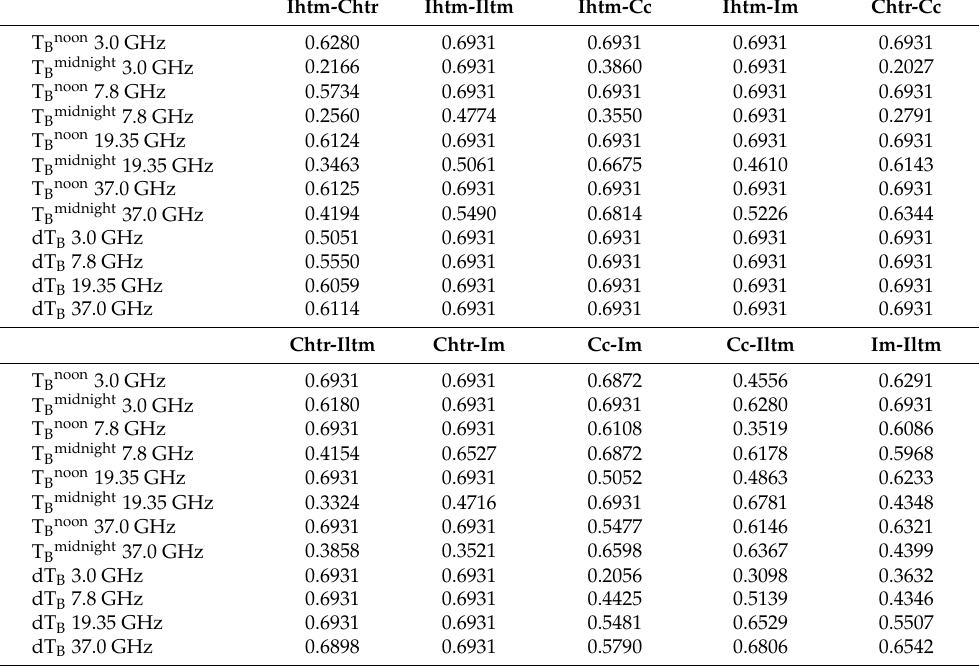
Table 2. J-S divergence between mare basalt